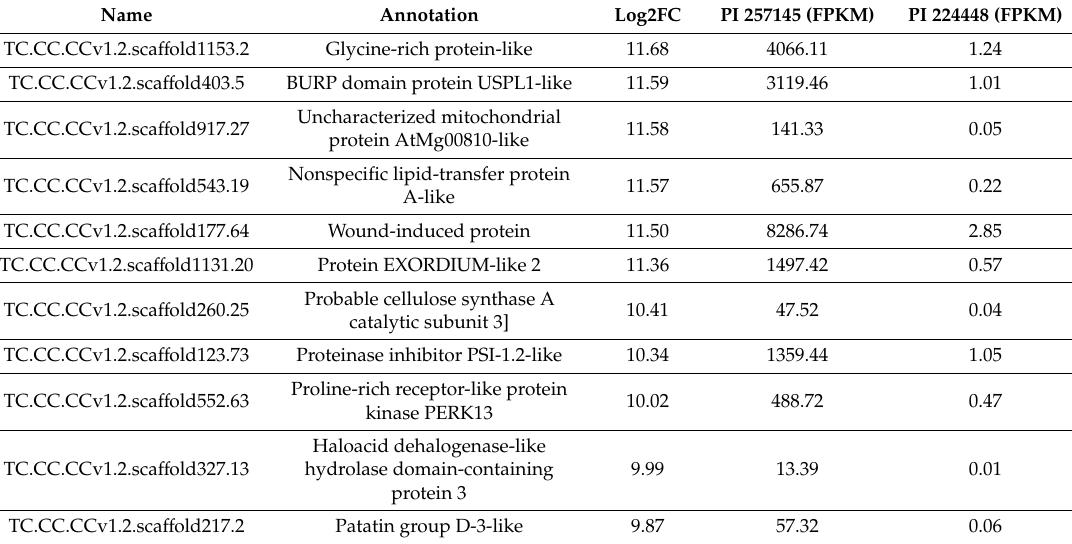
Table 3. Top 20 upregulated genes in PI 257145 versus PI